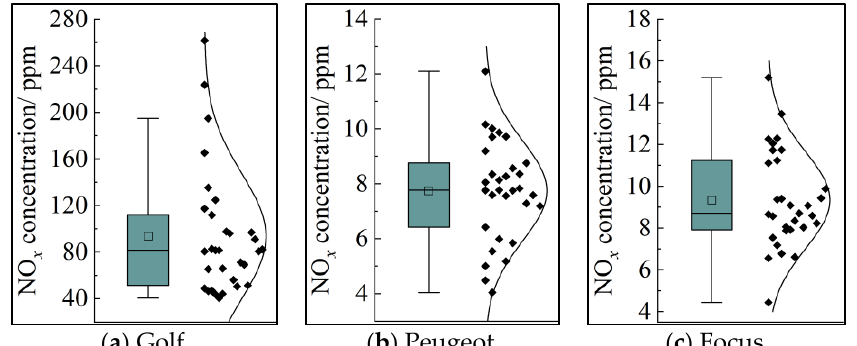
Figure 15. Average NO x concentration.